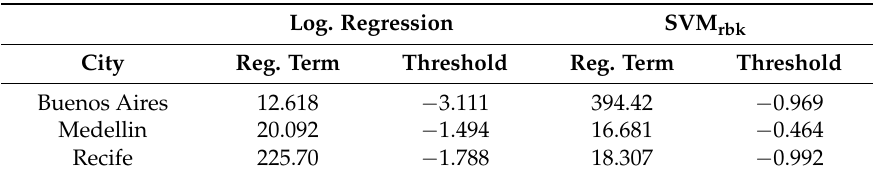
Table 7. Final parameters of the logistic regression and the SVM rbk . The values of the decision threshold for the logistic regression are reported in the x -axis, and are not bounded between 0 and 1. For both cases (Logistic Regression and SVM), more negative thresholds indicate the classifier is more prone to set an observation as slum.